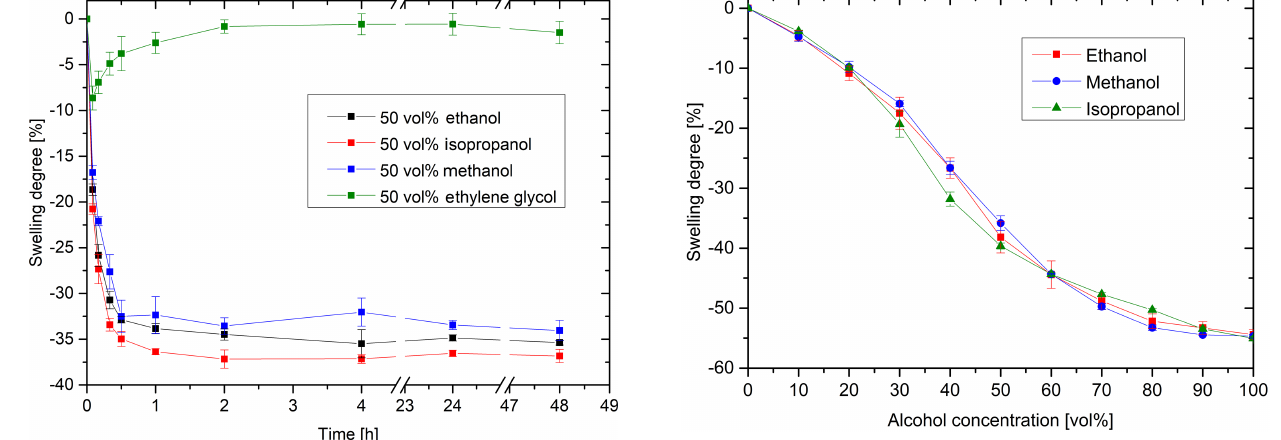
Figure 5. Swelling kinetics in ethanol, isopropanol, methanol and ethylene glycol (hydrogel: 10vol%Aam and 0.44mol%Bis).